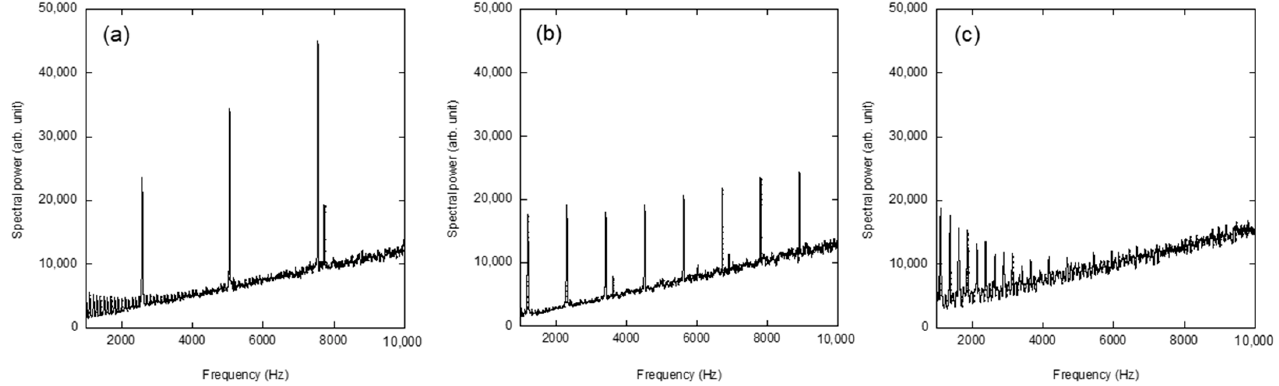
Figure 4. Laser-induced vibrational spectra of agarose with a Young’s modulus of 1.22 MPa with respect to different numbers of divisions: ( a ) 5 divisions, ( b ) 10 divisions, and ( c ) 40 divisions.